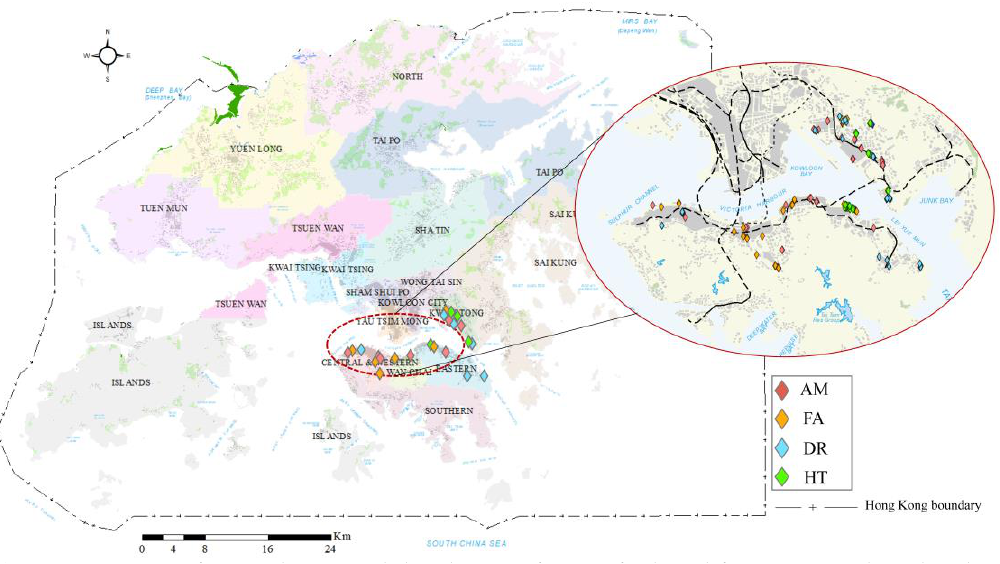
Figure 1. Location of research area and distribution of trees of selected four species. The colored icons in the dashed red circle indicate the general location of the selected four species. The icons in the solid red circle are specific sample locations of each species. Table 1. Basic structural information of trees of four species. Mean, Max and Min are average, maximum and minimum values of TH, CS and DBH,